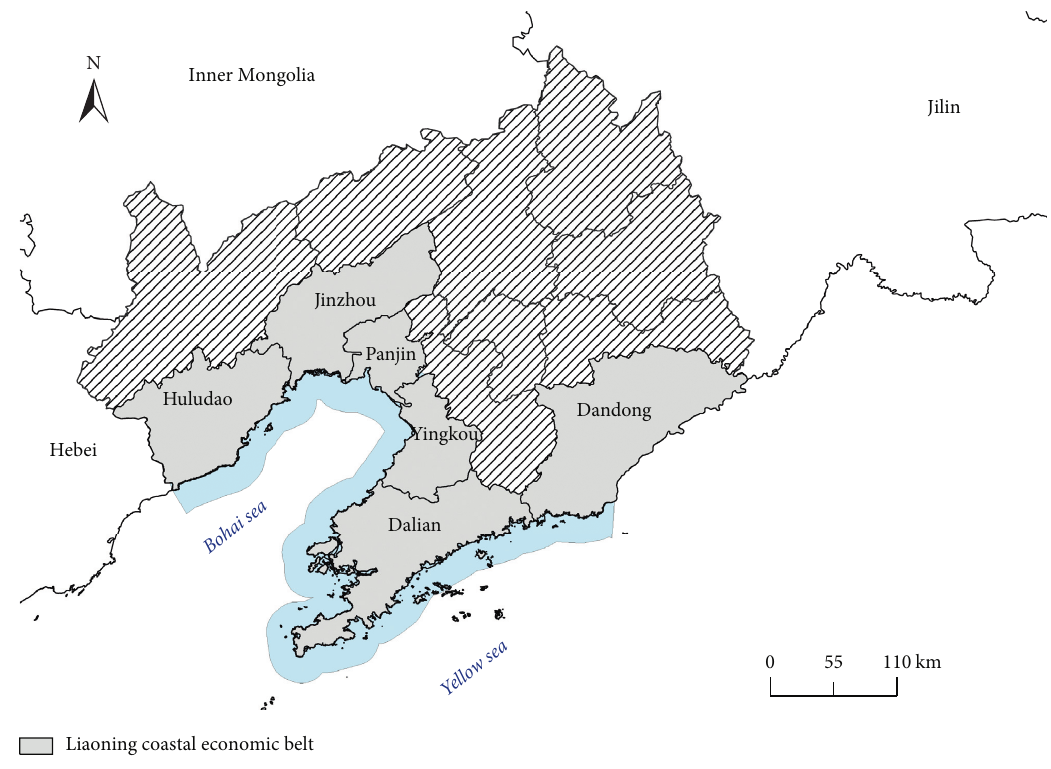
Figure 2: The geographical location of the research